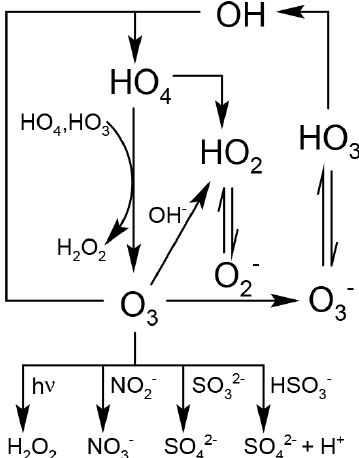
Figure 1. Graphical representation of inorganic aqueous-phase ozone chemistry based on Staehelin et al.